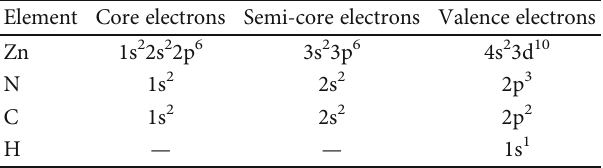
Figure 3: The calculated electronic band structure and density of states (DOS) of Zif-8 compounds. Table 3: Atomic orbitals as employed in the present band structure computation of